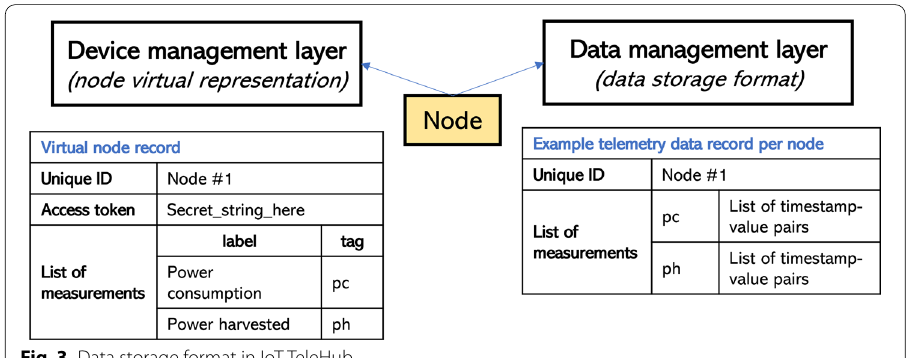
Fig. 3 Data storage format in IoT